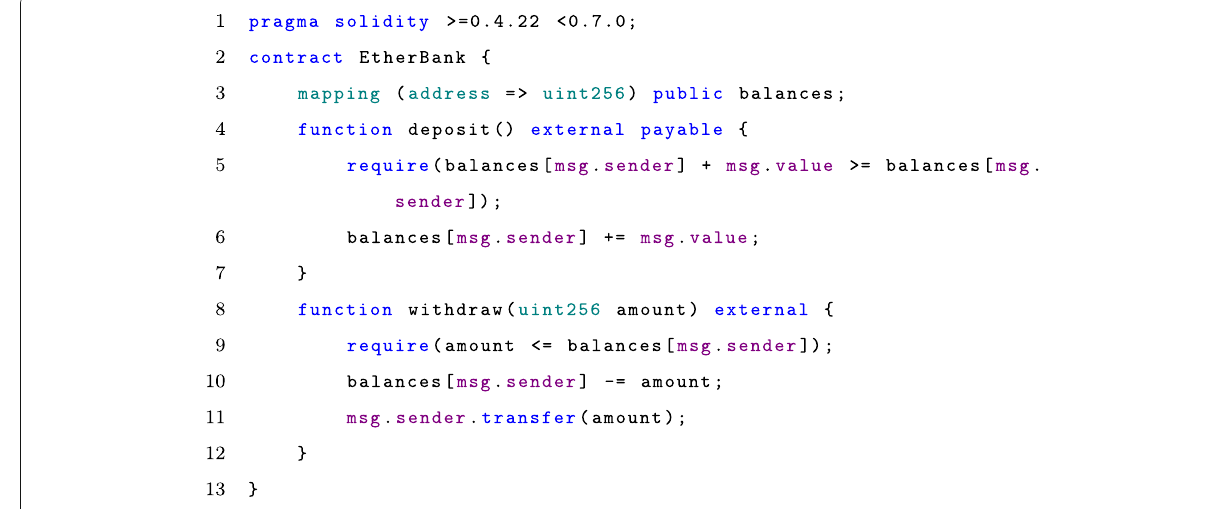
Fig. 1 EtherBank : an example smart contract written in Solidity